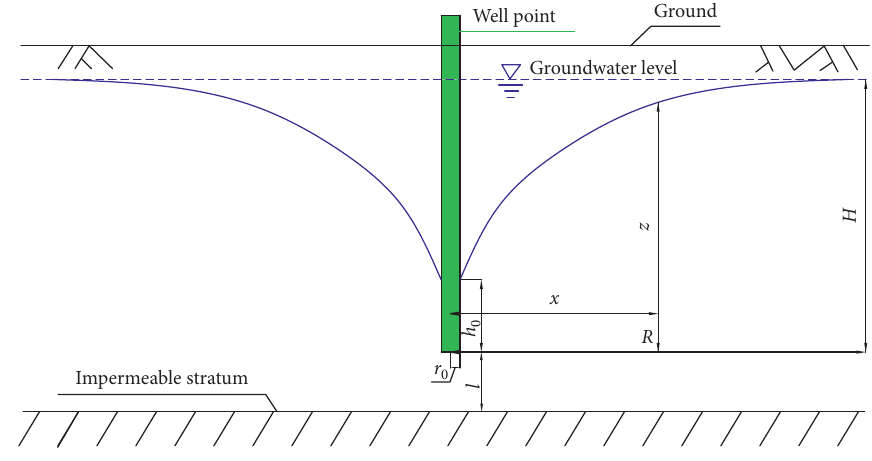
Figure 9: Dewatering funnel curve for the phreatic incomplete well